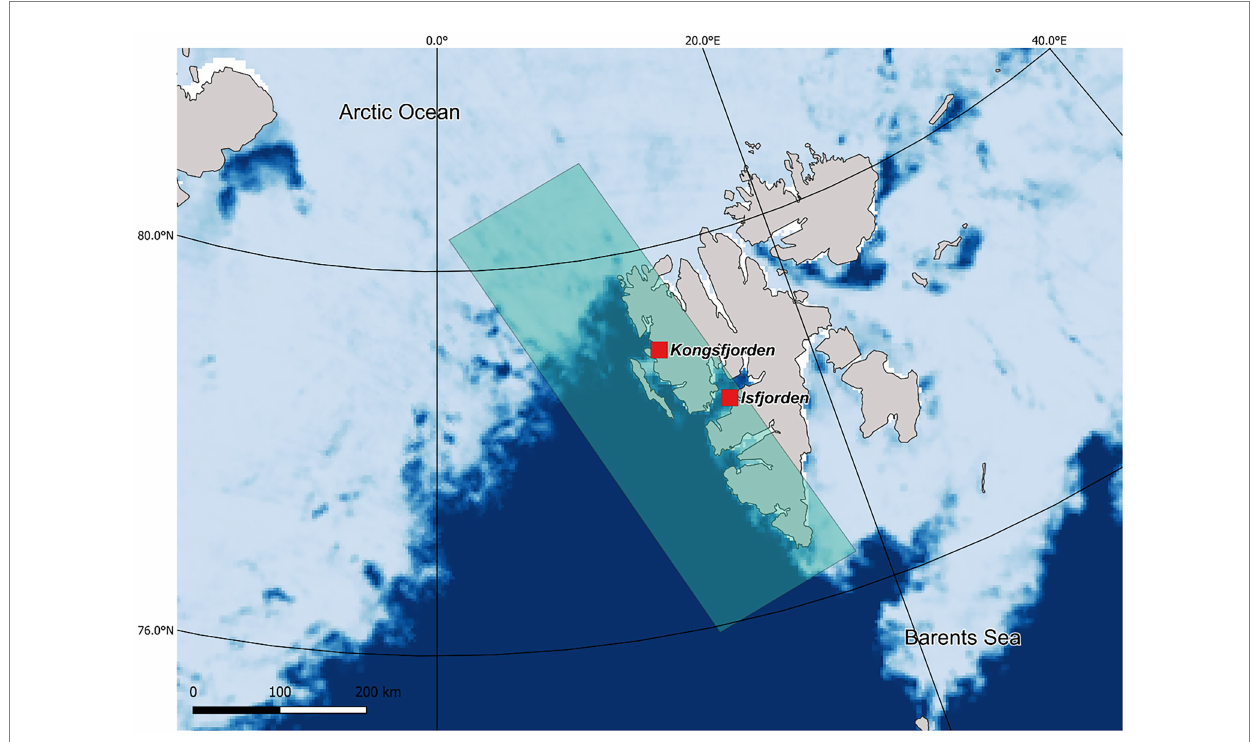
FIGURE 1 Study area at Spitsbergen (Svalbard, Norway). The red squares indicate the fjord locations. The shaded rectangle on the western coast of Spitsbergen represents the area from which the long-term time-series (1988–2018) of maximum sea-ice concentration data was extracted to evaluate the relationship between sea-ice conditions and seabirds’ population. For illustrative purposes, we include background colors pinpointing the seasonal ice zone. Dark blue indicates open water, the lighter the gradient the higher the concentration of sea-ice. White cells along the coastline indicate no data on